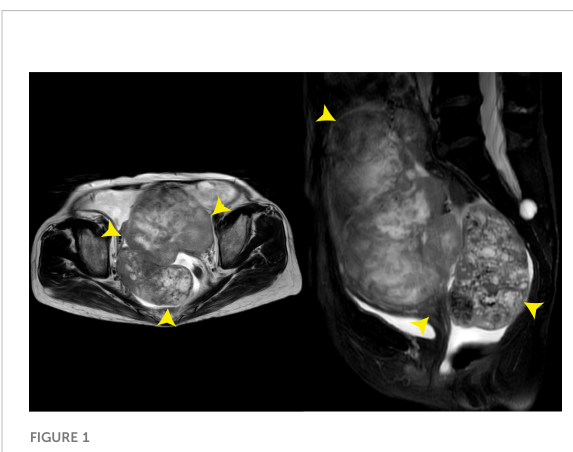
FIGURE 1 Pelvic MRI on 18 August 2020. The images showed an expansive heterogeneous malignant tumor in the lower abdominal and pelvic cavity (yellow arrows).